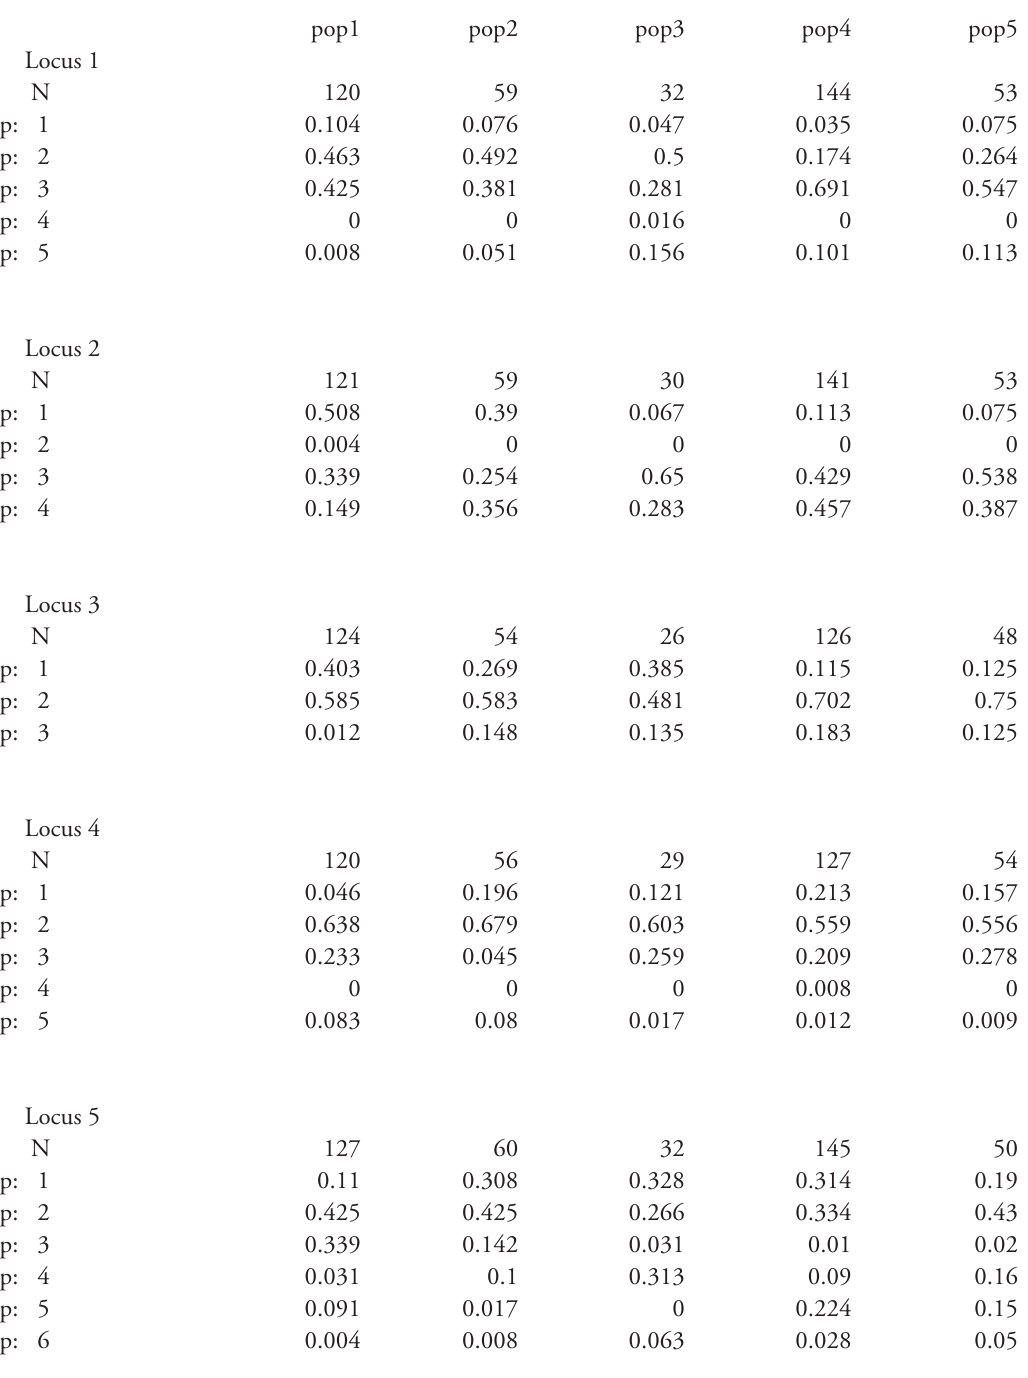
S3. Allele frequencies (p:) for 14 microsatellite loci in five Norwegian red deer subpopula-